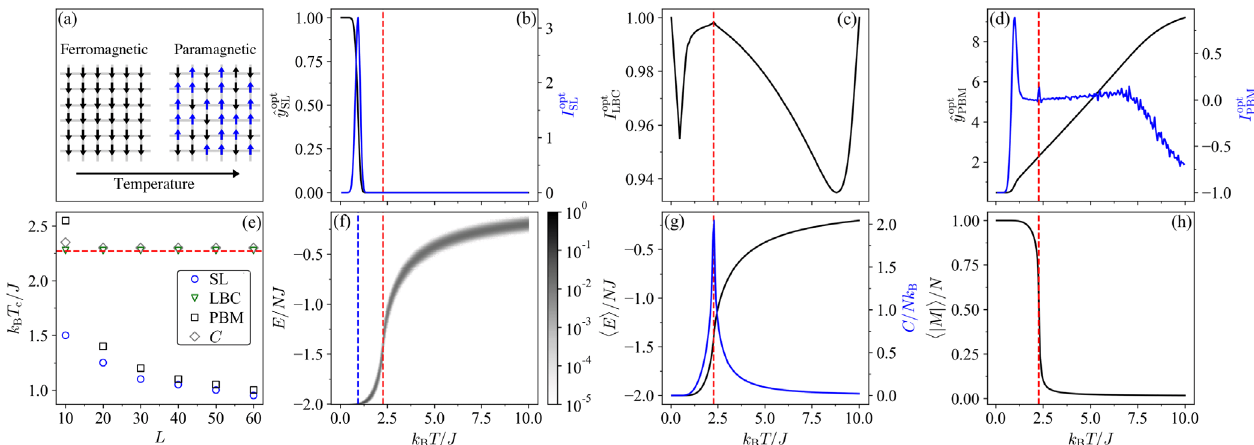
T=J , where p 1 ¼ 0 . 05 , FIG. 3. Results for the Ising model ( L ¼ 60 ) with the dimensionless temperature as a tuning parameter p ¼ k B 10 , and Δ p ¼ 0 . 05 . In SL, the data obtained at p 1 and l p K . The critical 1 and p K constitute our training set, i.e., r I ¼ K ¼ II ¼ temperature [Eq. (31)] is highlighted by a red dashed line. (a) Illustration of the symmetry-breaking phase transition in the Ising model. (b) Mean optimal prediction ˆ y opt in SL (black line) and the corresponding indicator I opt (blue line). (c) Optimal indicator of LBC, I opt SL SL LBC (black line). (d) Mean optimal prediction ˆ y opt in PBM (black line) and the corresponding indicator I opt (blue line). (e) Estimated PBM PBM critical temperatures based on I opt (SL), I opt (LBC), I opt (PBM), and heat capacity ( C ) as a function of the lattice size L . The estimated PBM SL LBC critical temperature based on the heat capacity corresponds to the location of its maximum. (f) Probability distributions governing the input data (here, the energy) as a function of the tuning parameter, where the color scale denotes the probability. The blue dashed line highlights the predicted critical temperature of SL and PBM. (g) Average energy per site (black line) and associated heat capacity (blue line) as a function of the temperature, where N ¼ L 2 . (h) Average magnetization per site as a function of the